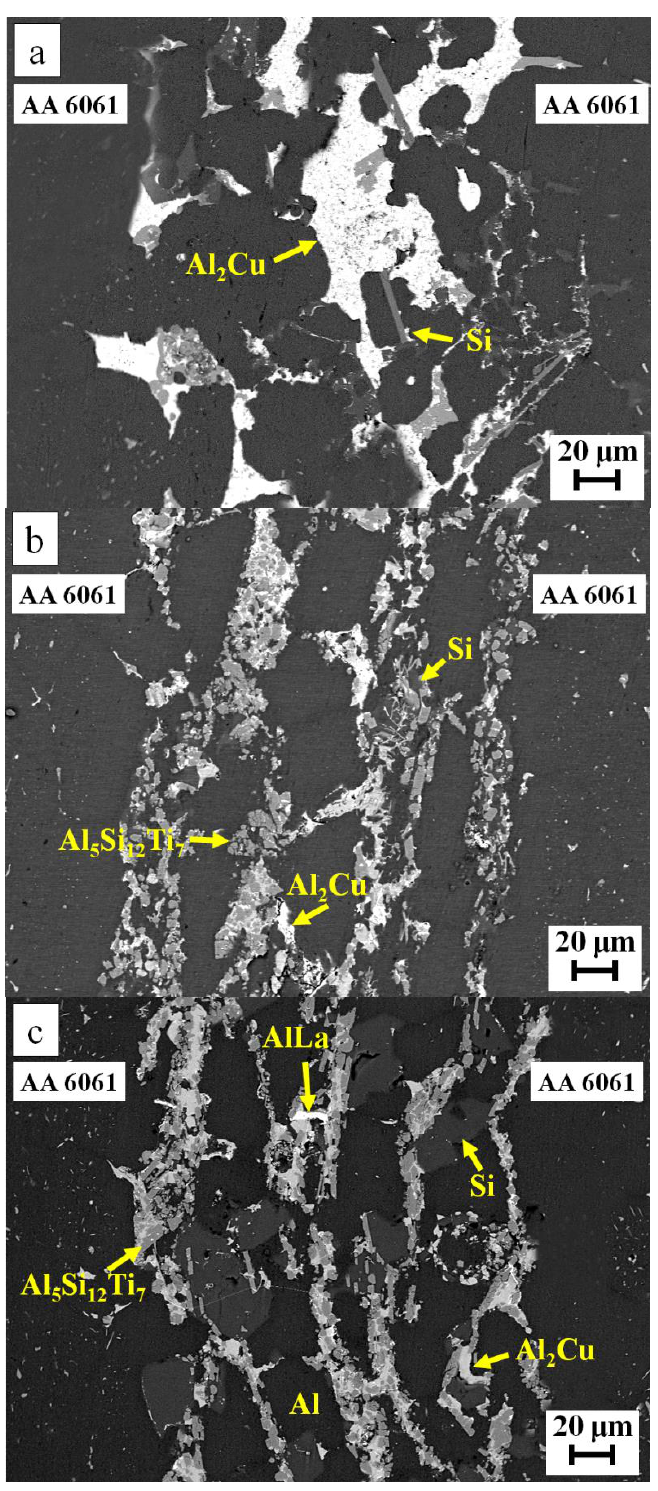
Figure 5. The microstructures under BSE mode of the AA6061 joints with ( a ) Al10.8Si10Cu, ( b ) Al10Si10Cu4Ti and ( c ) Al10Si10Cu4Ti0.1RE filler alloys after brazing at 530 °C for 10 min. The average joint shear strengths of the AA6061/AA6061 joints bonded with Al10.8Si10Cu, Al10Si10Cu4Ti and Al10Si10Cu4Ti0.1RE filler alloys were determined to be 39.8, 47.8 and 57.3 MPa. The highest joint shear strengths were 46.54, 51.5 and 61.1 MPa, respectively. The shear strengths of the joints increased significantly with the addition of active elements, as shown in Figure 6. Aluminum alloys are prone to form a dense oxide